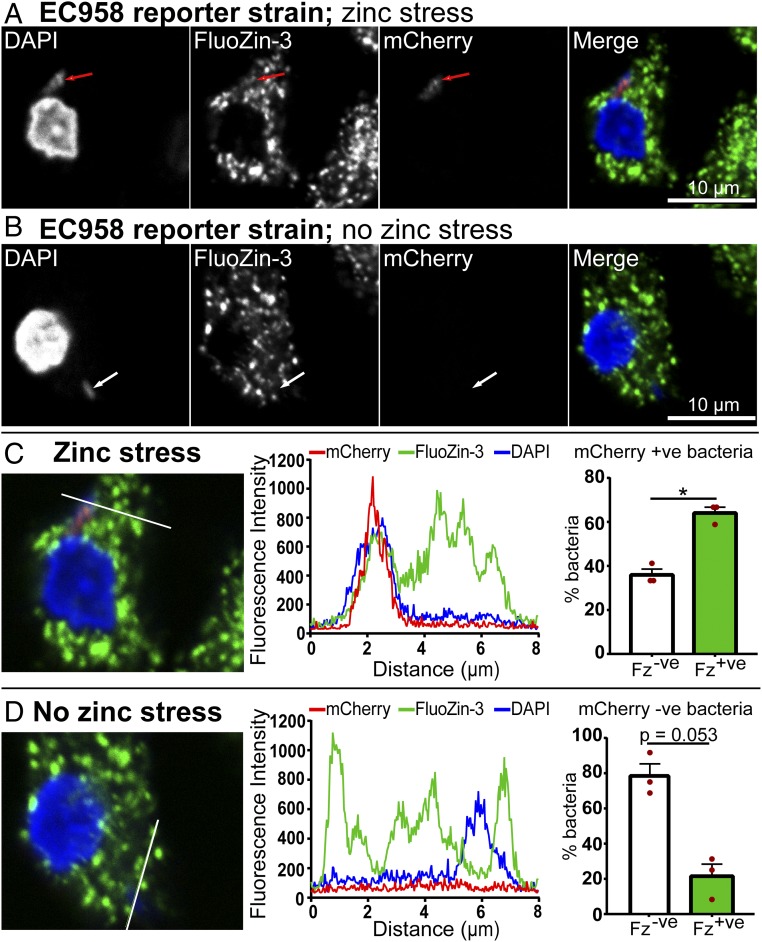
Zinc vesicles colocalize with EC958 that are experiencing zinc stress. (A–D) HMDM were infected with the EC958 pQF50-zntA-mCherry strain at an MOI of 100 for 1 h, followed by gentamicin exclusion. At 8, 16, or 24 hpi, cells were fixed and stained with DAPI and FluoZin-3, then imaged for mCherry, DNA, and zinc (FluoZin-3). Representative images at 24 hpi for mCherry+ and mCherry− EC958 pQF50-zntA-mCherry are displayed in A and B, respectively (white arrows: mCherry− bacteria; red arrows: mCherry+ bacteria). Data are from a single experiment and are representative of three experiments. (C and D) For single-plane images from A and B, respectively (magnification: 63×), fluorescence intensity of mCherry, FluoZin-3, and DAPI were assessed over a linear segment (histograms, Center), as indicated by white lines (Left). Images are from one experiment and are representative of three independent experiments. Images were also analyzed using a custom written, user-interactive ImageJ macro, enabling mCherry+ and mCherry− bacteria to be assigned to “no colocalization” (unfilled bars = Fz−, graphical data, Right) or “colocalization” (green-filled bars = Fz+, graphical data, Right) with a FluoZin-3-marked zinc vesicle. The percentage colocalization was then determined for each experiment (with at least four images quantified in each experiment). Data (mean + SEM, n = 3) are combined from three experiments, and were analyzed using a paired t test (*P < 0.05).